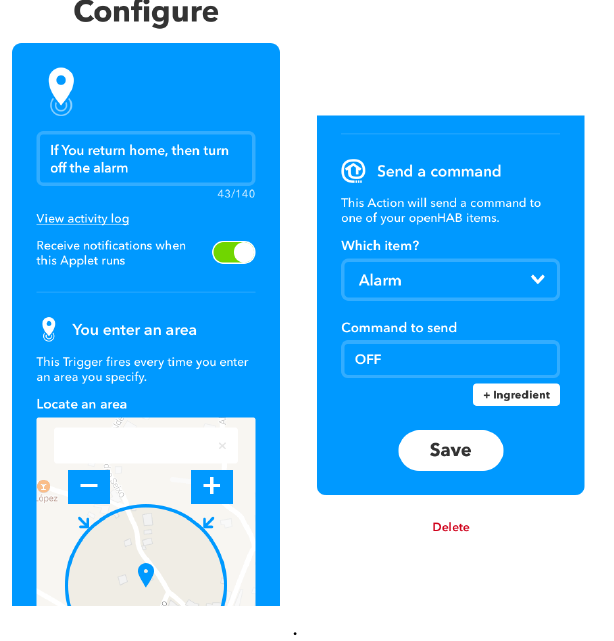
Figure 12. Example of the creation of a rule using